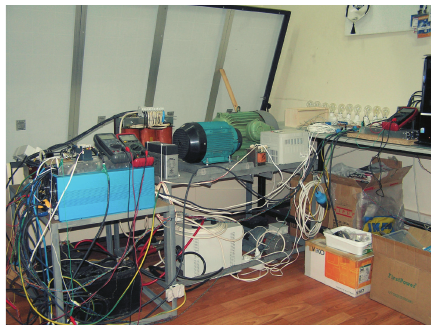
Figure 13: Appearance of experimental system on one side.